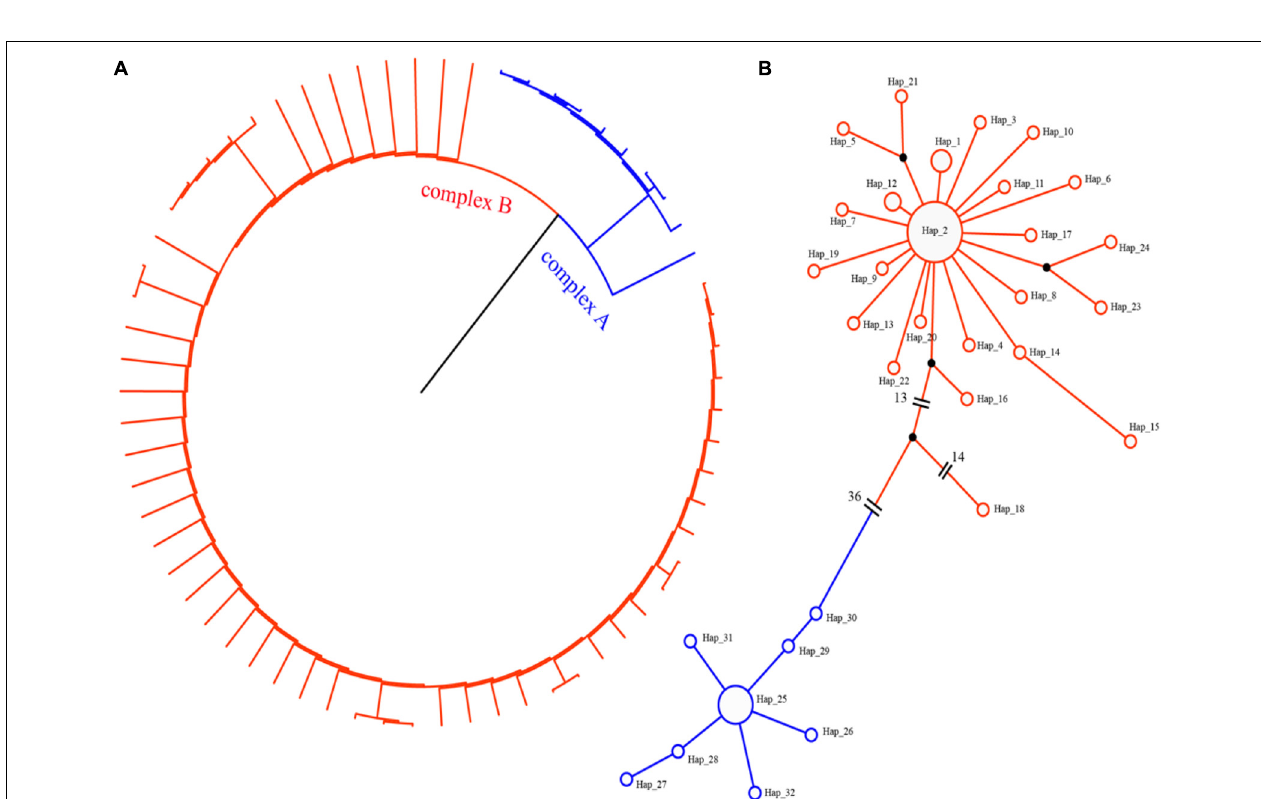
FIGURE 4 | Haplotype network diagram and phylogenetic tree. (A) Phylogenetic tree. (B) Haplotype network diagram. Circles denote haplotypes. Circle size corresponds to the proportion of a specific haplotype out of 65 samples; red represents the jujube group, while blue represents sour-jujube group.